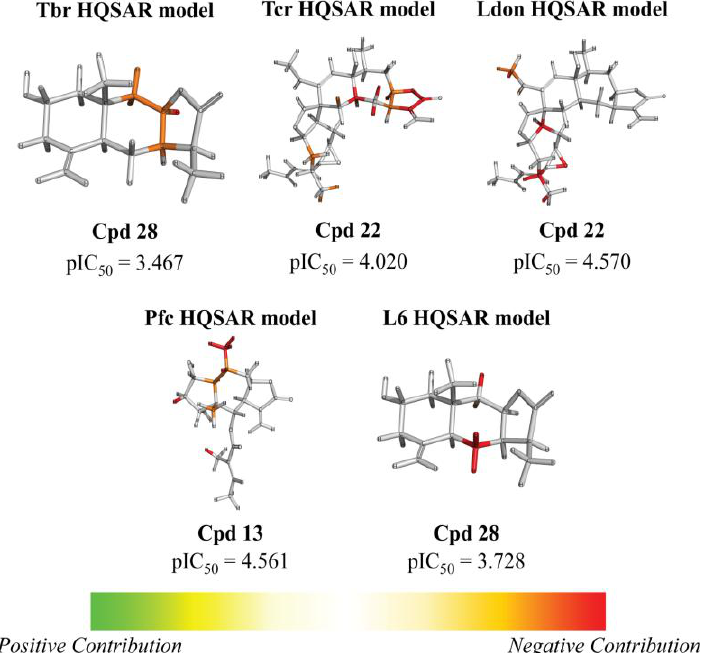
Figure 5. HQSAR maps of negative contribution for all five constructed HQSAR models.